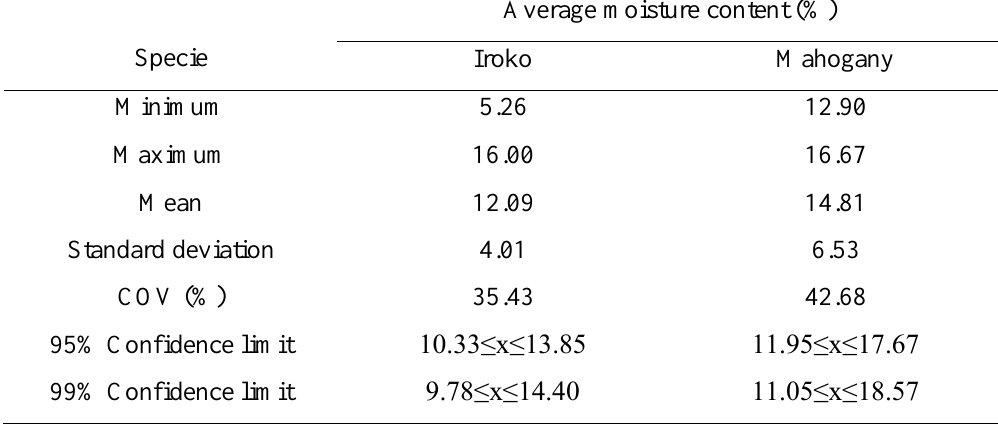
The average moisture content of Iroko and Mahogany.